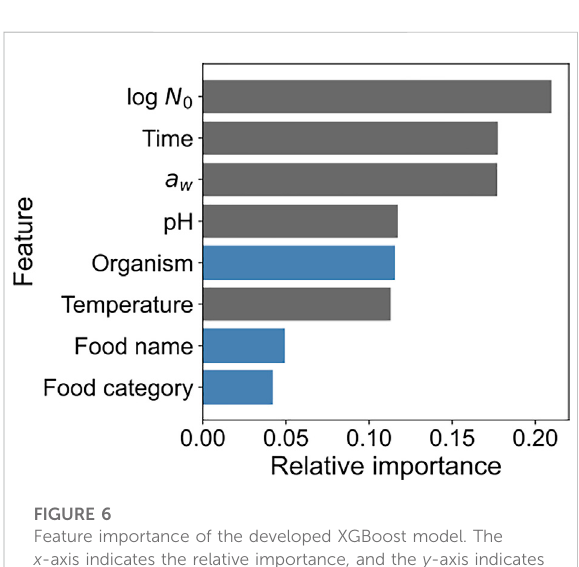
FIGURE 6 Feature importance of the developed XGBoost model. The x -axis indicates the relative importance, and the y -axis indicates the feature names. Blue and gray bars indicate categorical and numerical variables,